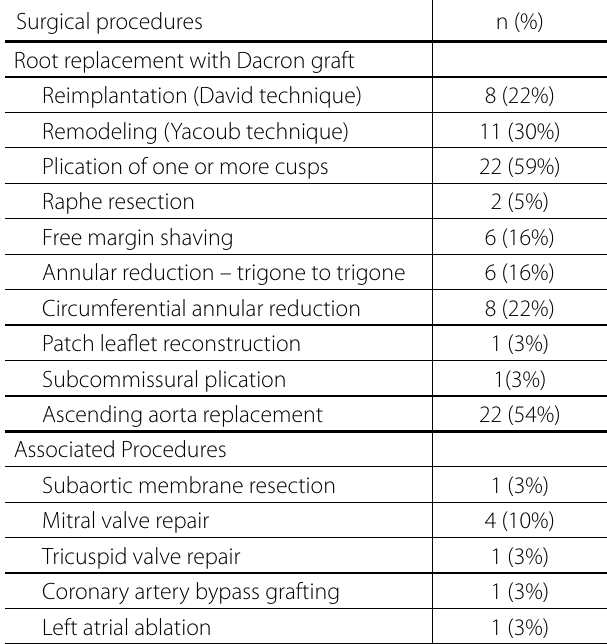
Table 2. Surgical data. Surgical procedures